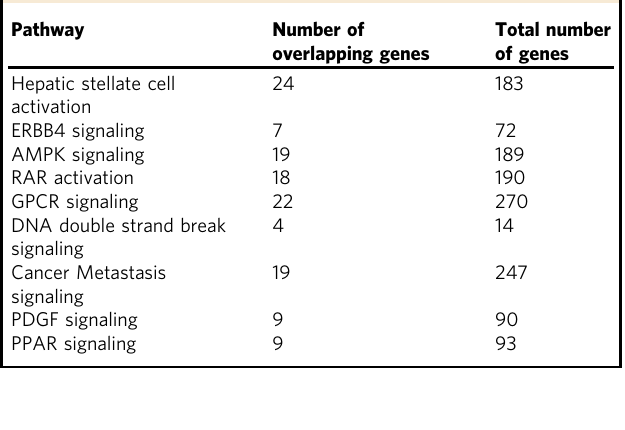
quality using Trimmomatic v0.36 48 and the following parameter settings: Lead- ing:10; Trailing:10; Sliding window:4:20; Minlen:20). Reads were then mapped to the hs37d5 (with decoys; ftp://ftp.1000genomes.ebi.ac.uk/vol1/ftp/technical/refer- ence/phase2_reference_assembly_sequence/hs37d5.fa.gz) reference genome using